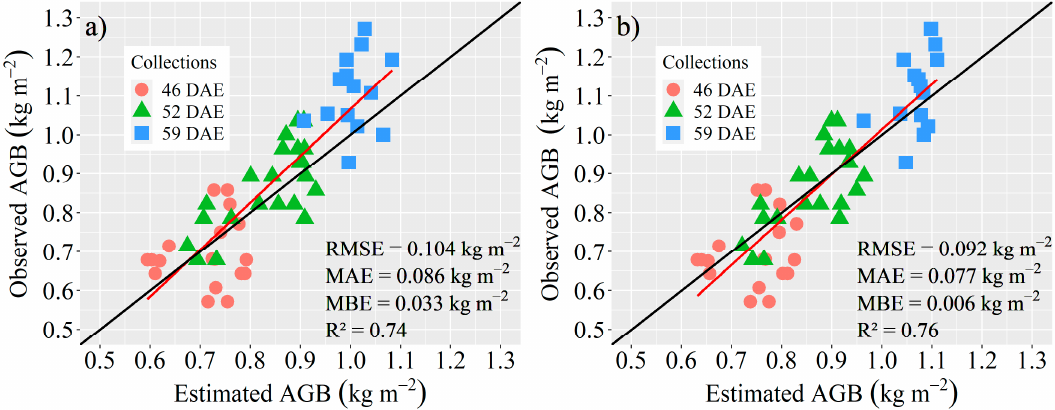
Figure 12. Statistical evaluation between the biomass estimated by the models derived from the NDVI ( a ) and SAVI ( b ) and the biomass measured in the field.